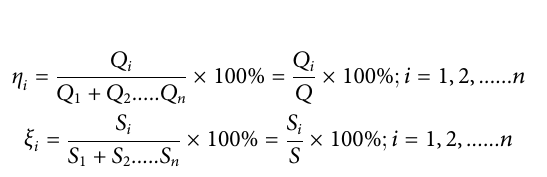
FIGURE 3 | Calculation process of waterway depth, ratios of water and sediment. (A) Determination of lowest navigable water level; (B) Waterway water depth calculation process; (C) Calculation of navigation obstruction ratios of water and sediment.